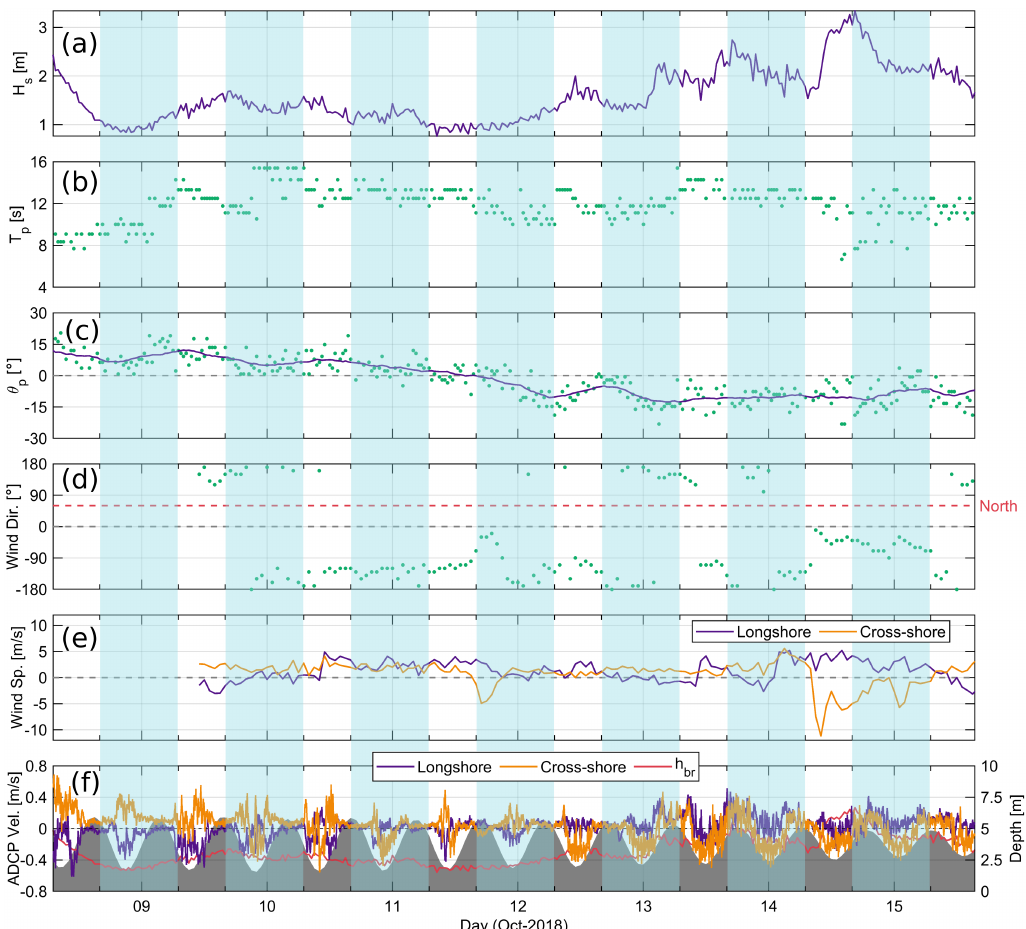
Figure 2. Field conditions during the 1-week (8–15 October 2018) continuous ADCP recording. Offshore ( a ) significant wave height ( H s ), ( b ) peak wave period ( T p ) and ( c ) peak wave angle of incidence relative to the shore normal ( θ p ; green dots) and its 12 h-averaged values (purple line). ( d ) Wind direction; wind incidence relative to the shore normal (green dots). The red line shows the north direction with respect to the shore normal (60°). ( e ) Longshore (purple line) and cross-shore (orange line) wind speed components. ( f ) ADCP 5-min time-averaged surface longshore (purple line) and cross-shore (orange line) velocity components. Positive cross-shore (longshore) surface velocities values correspond to an offshore-directed (directed away from the headland) current (see Figure 1). The latter convention is the same for the wind speed components. The gray filled area represents the water depth time series at the ADCP location and the red line shows the temporal evolution of wave breaking water depth ( h br ) defined as h br = H s /0.5. Non-shaded regions indicate video recording during daylight hours (blue shaded regions corresponds to nightlight hours). Field conditions during the drifter experiment are shown in Table 1, as drifters were deployed on 18, 19, 22 and 23 October 2018 outside of the 1-week ADCP recording